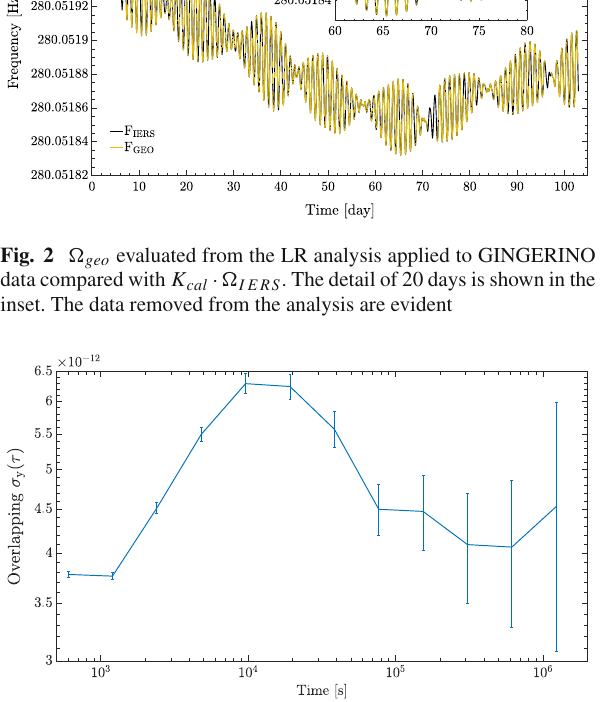
Fig. 3 Typical Overlapping Allan Deviation of residuals Δ M LR , rel- ative to mean ω s . Note that it is a factor 300 below the fundamental physics